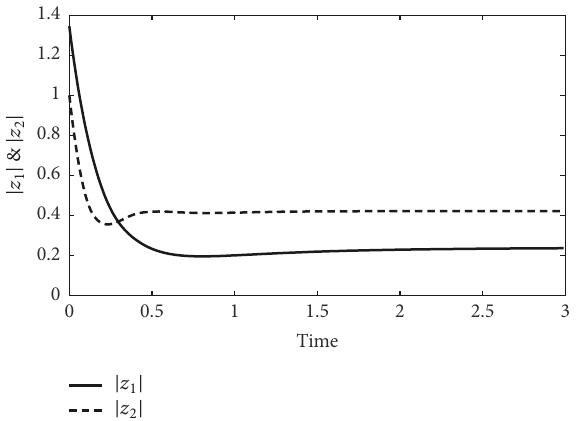
Figure 3: State curves of |𝑧 1 | and |𝑧 2 | without impulsive disturban- ces.